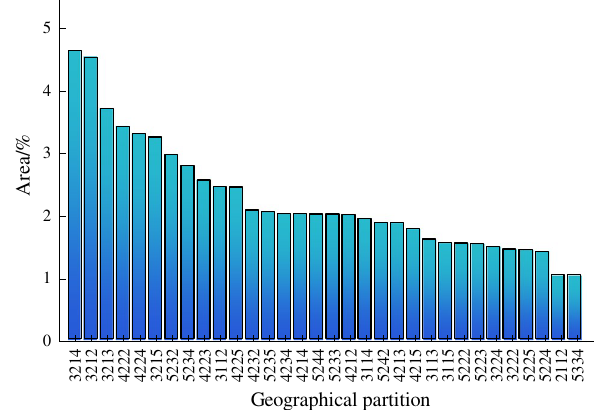
Figure 8. Statistical results of geographical